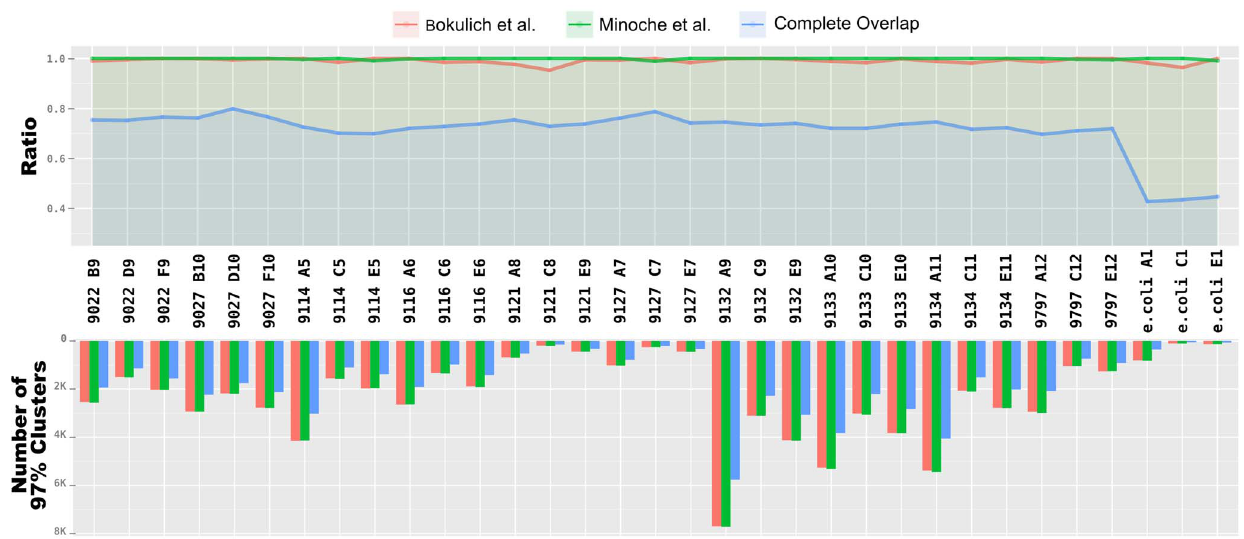
Figure 4. Comparison of the relative cluster counts and the absolute number of clusters identified in reads filtered by three different methods. The top panel shows the relative number of 97% OTUs for each method, with the method that produced the largest number assigned a value of 1.0. The bottom panel presents the actual number of OTUs for each method.